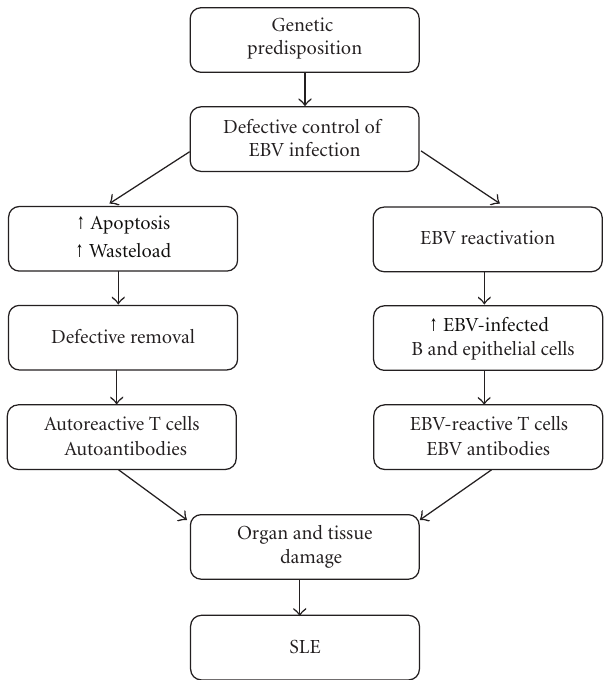
Figure 2: Hypothesis of development of SLE from EBV infection. Genetic insu ffi ciencies may result in poor control and thereby more frequent reactivation of the latent EBV infection. The increased number of EBV-infected cells will, upon apoptosis, initiate an innate and adaptive immune response against the released cellular antigens and EBV antigens due to defective removal of waste products. This will result in production of autoantibodies and EBV antibodies as an attempt to control the virus-induced inflammation. Furthermore, activation of both autoreactive and EBV-reactive T cells will occur. The response from the immune system cause organ and tissue damage leading to development of